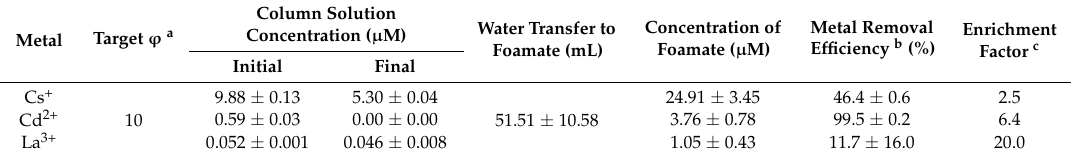
Table 3. Results of ion flotation for mixed metal solutions of Cs + , Cd 2+ , and La 3+ in triplicate columns (n = 3). Column conditions: 250 mL volume, pH 7.0 ± 0.1, 50 mL min −1 airflow, 100 µM